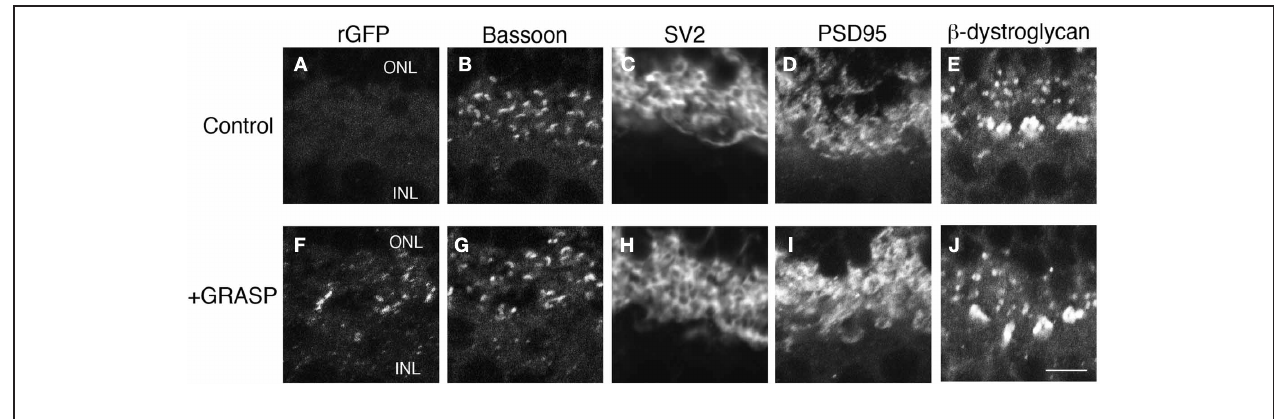
FIGURE 5 | Prolonged expression of GRASP has no obvious effect on the molecular architecture of photoreceptor synapses. (A–E) OPL of 7 month-old control mice were stained with anti-rGFP (A) and antibodies to synaptic markers: bassoon at active zones (B) , SV2 in synaptic vesicles